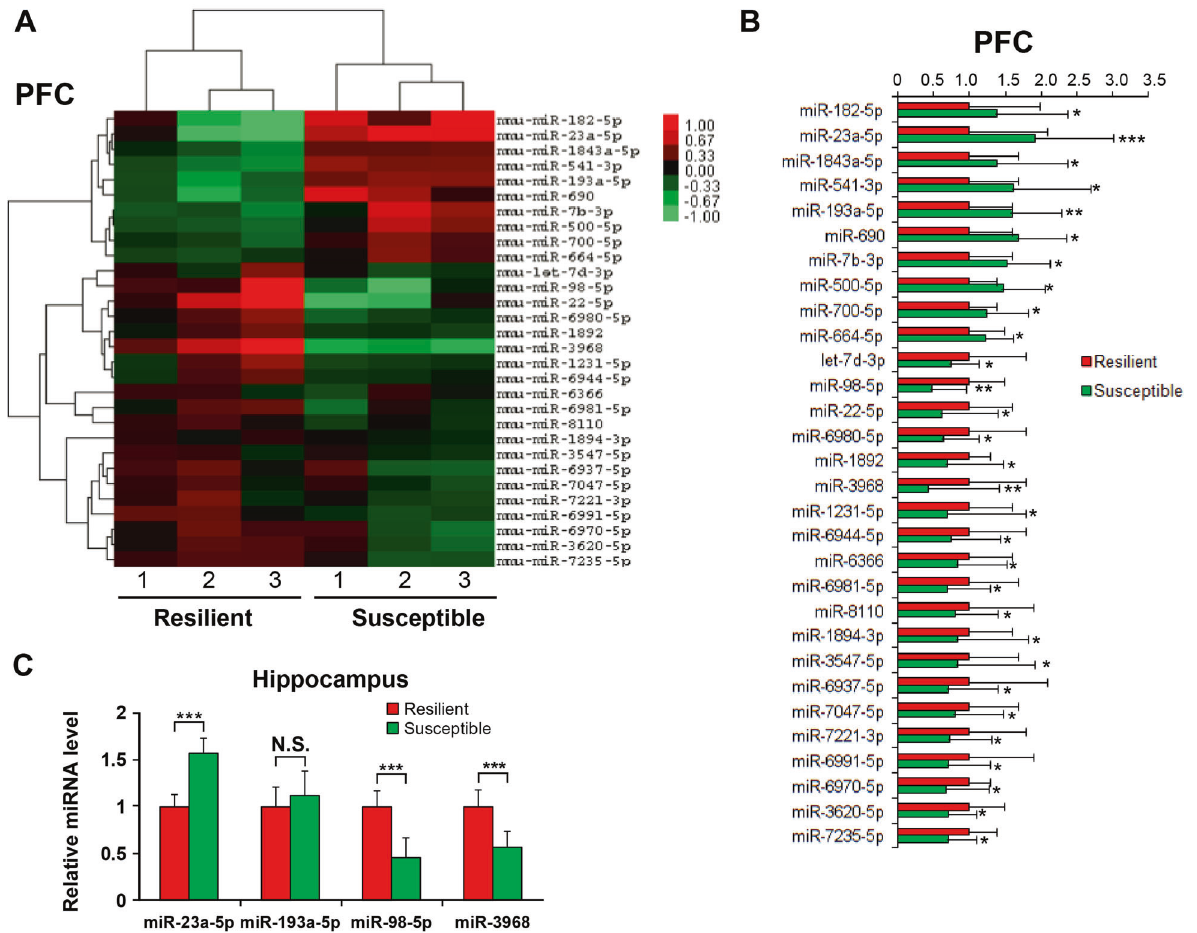
Fig. 2 miRNA expressions in PFC and hippocampus of CSDS-resilient and -susceptible mice. a Heat map of microarray results. The rows indicate miRNAs and columns indicate samples. The red color represents upregulation and the green color represents downregulation. b Relative expression levels of the differentially expressed miRNAs detected in the microarray. c Relative expression levels of miR-23a-5p, miR- 193a-5p, miR-98-5p, and miR-3968. qPCR was performed to assay the miRNA expressions in the hippocampus of CSDS-resilient and -susceptible mice. Data are shown as mean ± SEM ( n = 3). * P < 0.05; ** P < 0.01; *** P < 0.001; N.S. not signi fi GenePix Pro 6.0 software (Axon Instruments, Foster City, CA, USA) for grid alignment and data extraction. miRNAs, whose intensities are more than 50 in all samples, were used to calculate a normalization factor. Expressed data were normalized by median normalization. After normalization, the miRNAs that were signi fi cantly differentially expressed were identi fi ed through Volcano Plot fi ltering. Finally, the data were subjected to hierarchical clustering and depicted in a heat-map format using Gene- Spring GX software v7.3 (Agilent Technologies, California, United States). Statistical analysis The data were expressed as the mean ± standard error of the mean (SEM).